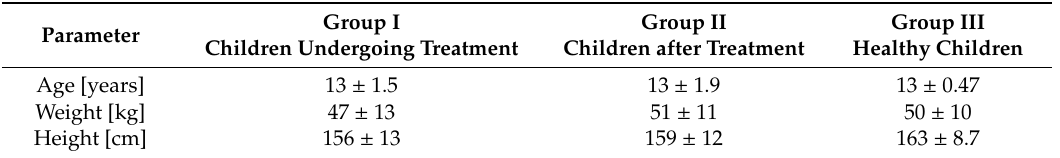
Table 1. Characteristics of the study